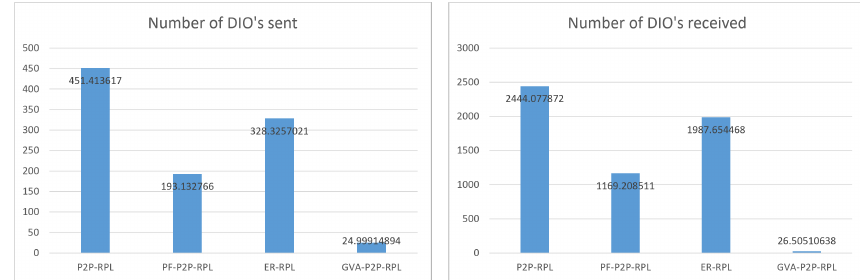
Figure 16. Number of DIOs sent and number of DIOs received.